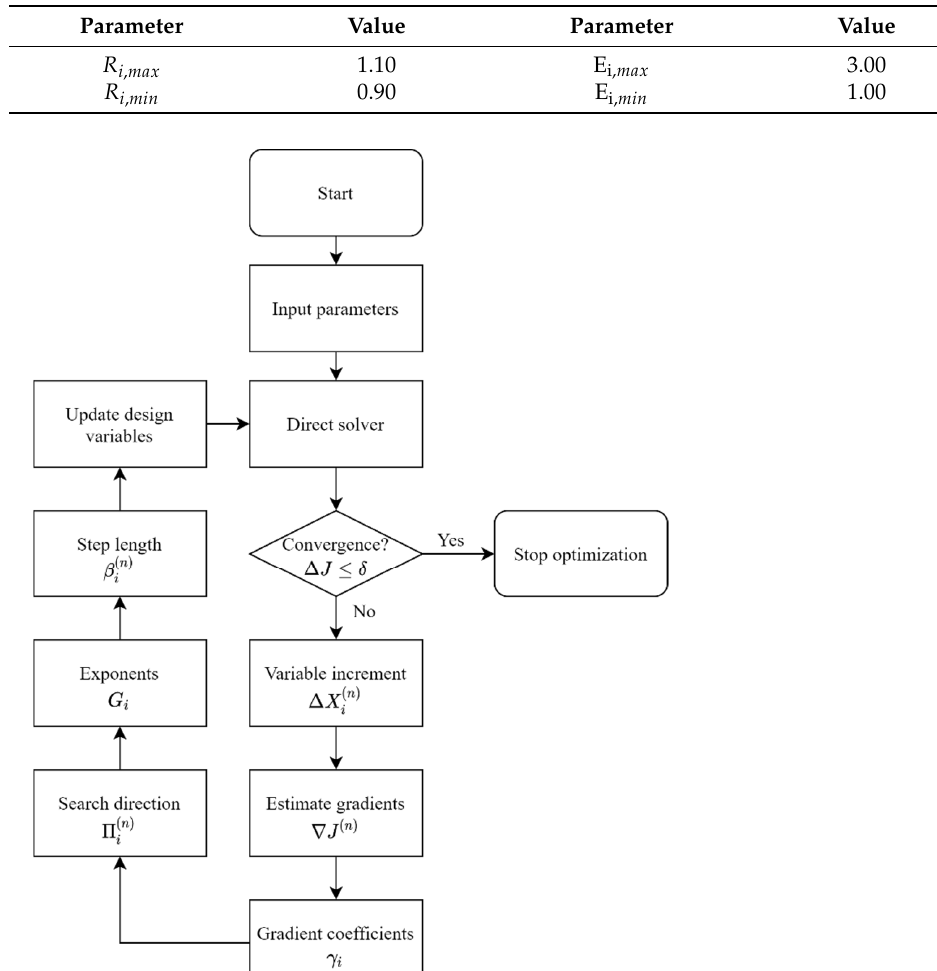
Table 1. Specifications of the VSCGM.